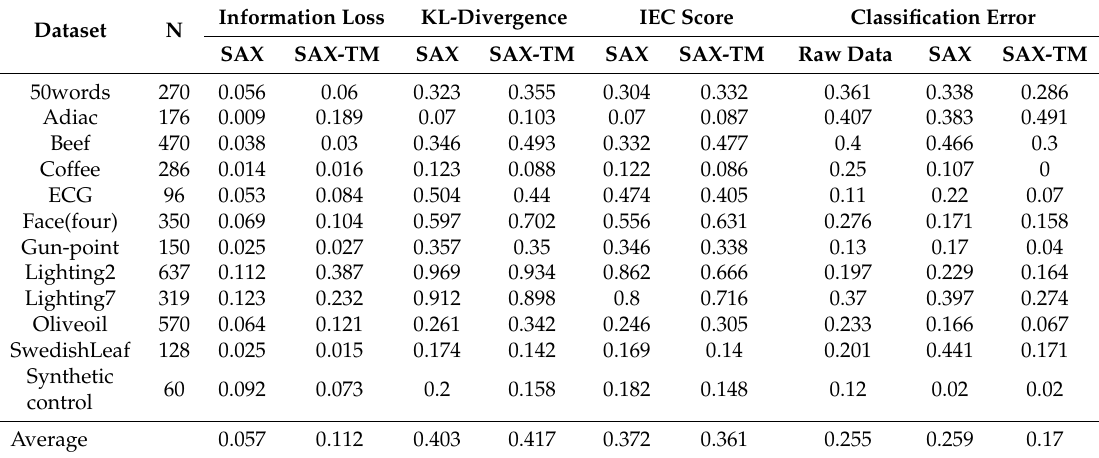
Table 4. Information loss and efficiency of information embedding in SAX and